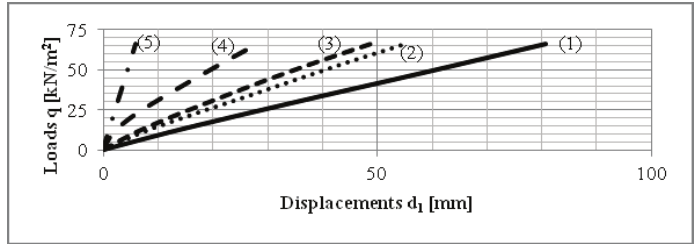
Fig. 4d. Displacements d x (mm) depending on the use of sheet piles as a cover of the foundation. Vertical load applied at the bearing points